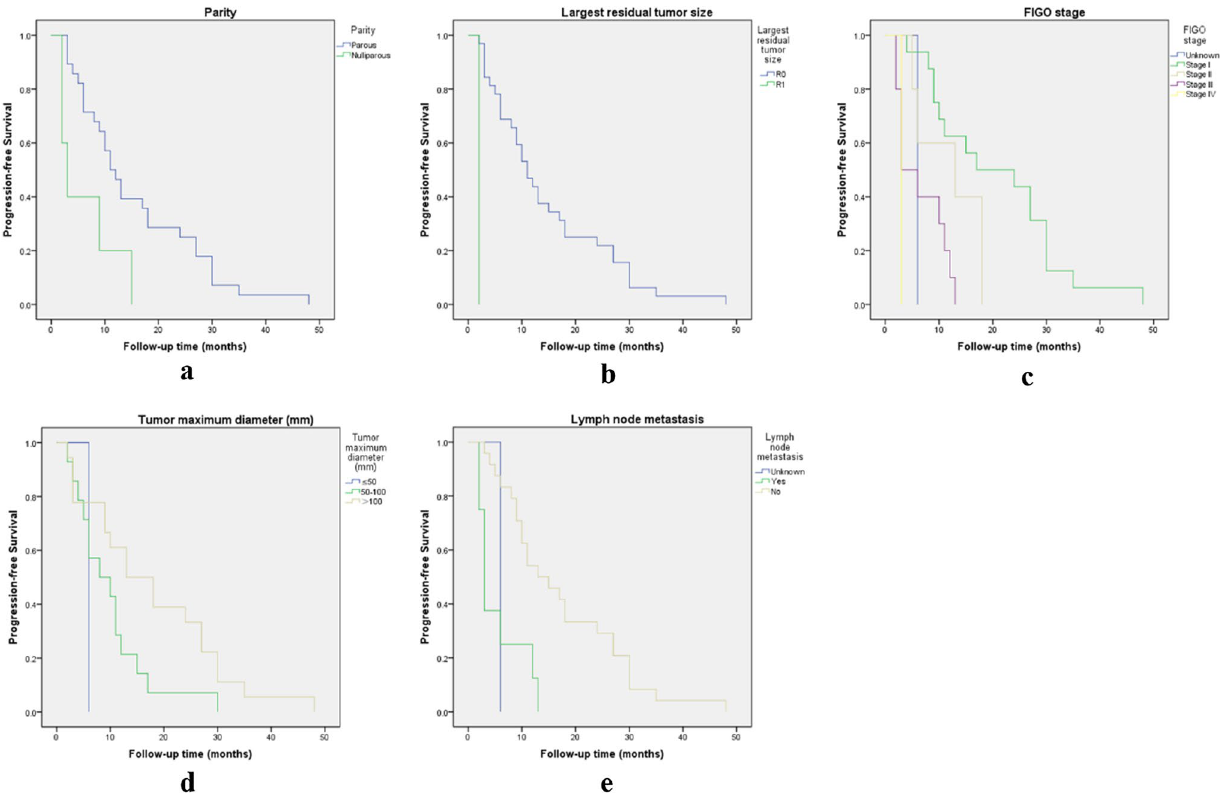
Fig. 3 ( a , b , c , d , e ). Survival curves of prognostic factors for progression-free survival by child-bearing history ( a ), largest residual tumor size ( b ), FIGO stage ( c ), tumor maximum diameter ( d ), lymph node metastasis ( e ) Table 4 Multivariate analyses of significant prognostic parameters on overall survival in patients with ovarian clear cell carcinoma cox-regression